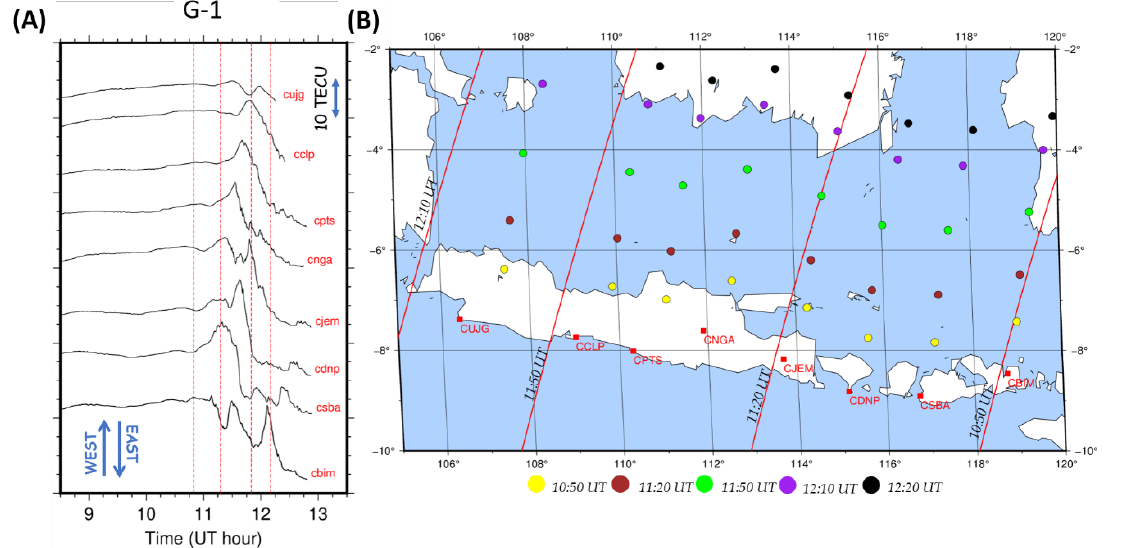
Figure 2. ( A ) Time series of VTEC from G1 satellite on 15 January 2022, at eight GNSS stations in Java, Bali, and Nusa Tenggara Timur. They show significant disturbance signatures, reflecting passages of LW from the HTHH volcano. Red broken lines correspond to times for which wavefronts of LW are given in the map. ( B ) A map showing the station positions, and SIPs (coloured circles) and LW wavefronts (red lines) at four epochs shown as vertical lines in the time series.